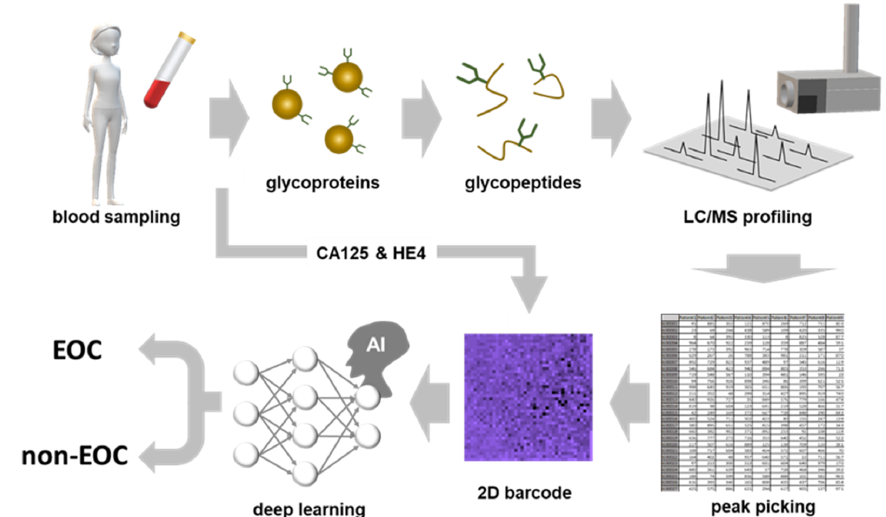
Figure 4. The whole scheme of artificial intelligence-based comprehensive serum glycopeptide spectra analysis (CSGSA-AI). The glycopeptides obtained by trypsin digestion of serum proteins were enriched and analyzed by the QTOF-type mass spectrometer. The expression levels of target glycopeptides were converted into 2D barcodes, and they were colored on the basis of serum CA125 and HE4 levels. After the CNN was trained by the supervised cases, it distinguished the barcodes generated from samples being screened into EOC or non-EOC.